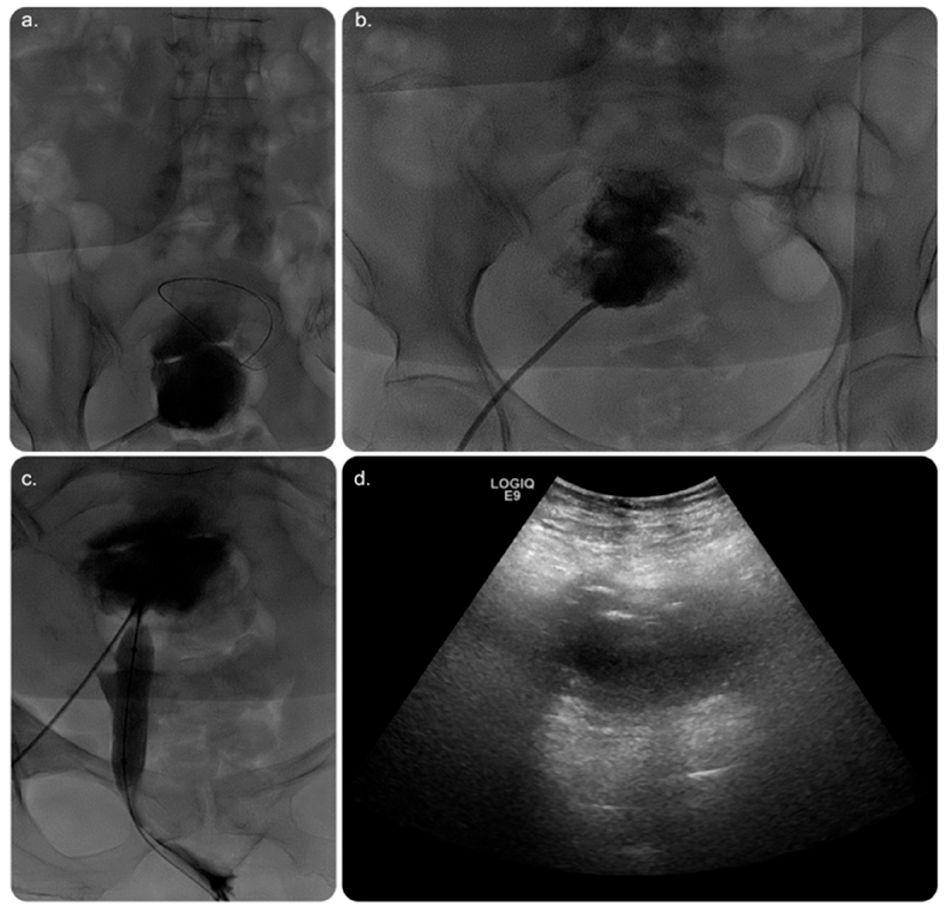
Figure 4. ( a ) Fluoroscopic image of the pelvis showing a wire being introduced through the same access to be directed into the cervix with a trial to negotiate the obstruction. ( b ) Fluoroscopic image showing a catheter being used to direct the wire into the cervix. ( c ) Fluoroscopic image after successfully crossing the cervical stenosis/occlusion with free passage of contrast through the vagina. The wire can be seen projecting through the vagina to outside the body. A stretching balloon was used to dilate the stenosed/obstructed area of the cervix to prevent possible future recurrence of the stenosis. ( d ) Grey-scale ultrasound image performed on day 1 postoperatively, showing significant improvement in the collection with minimal residual amount of the collection.